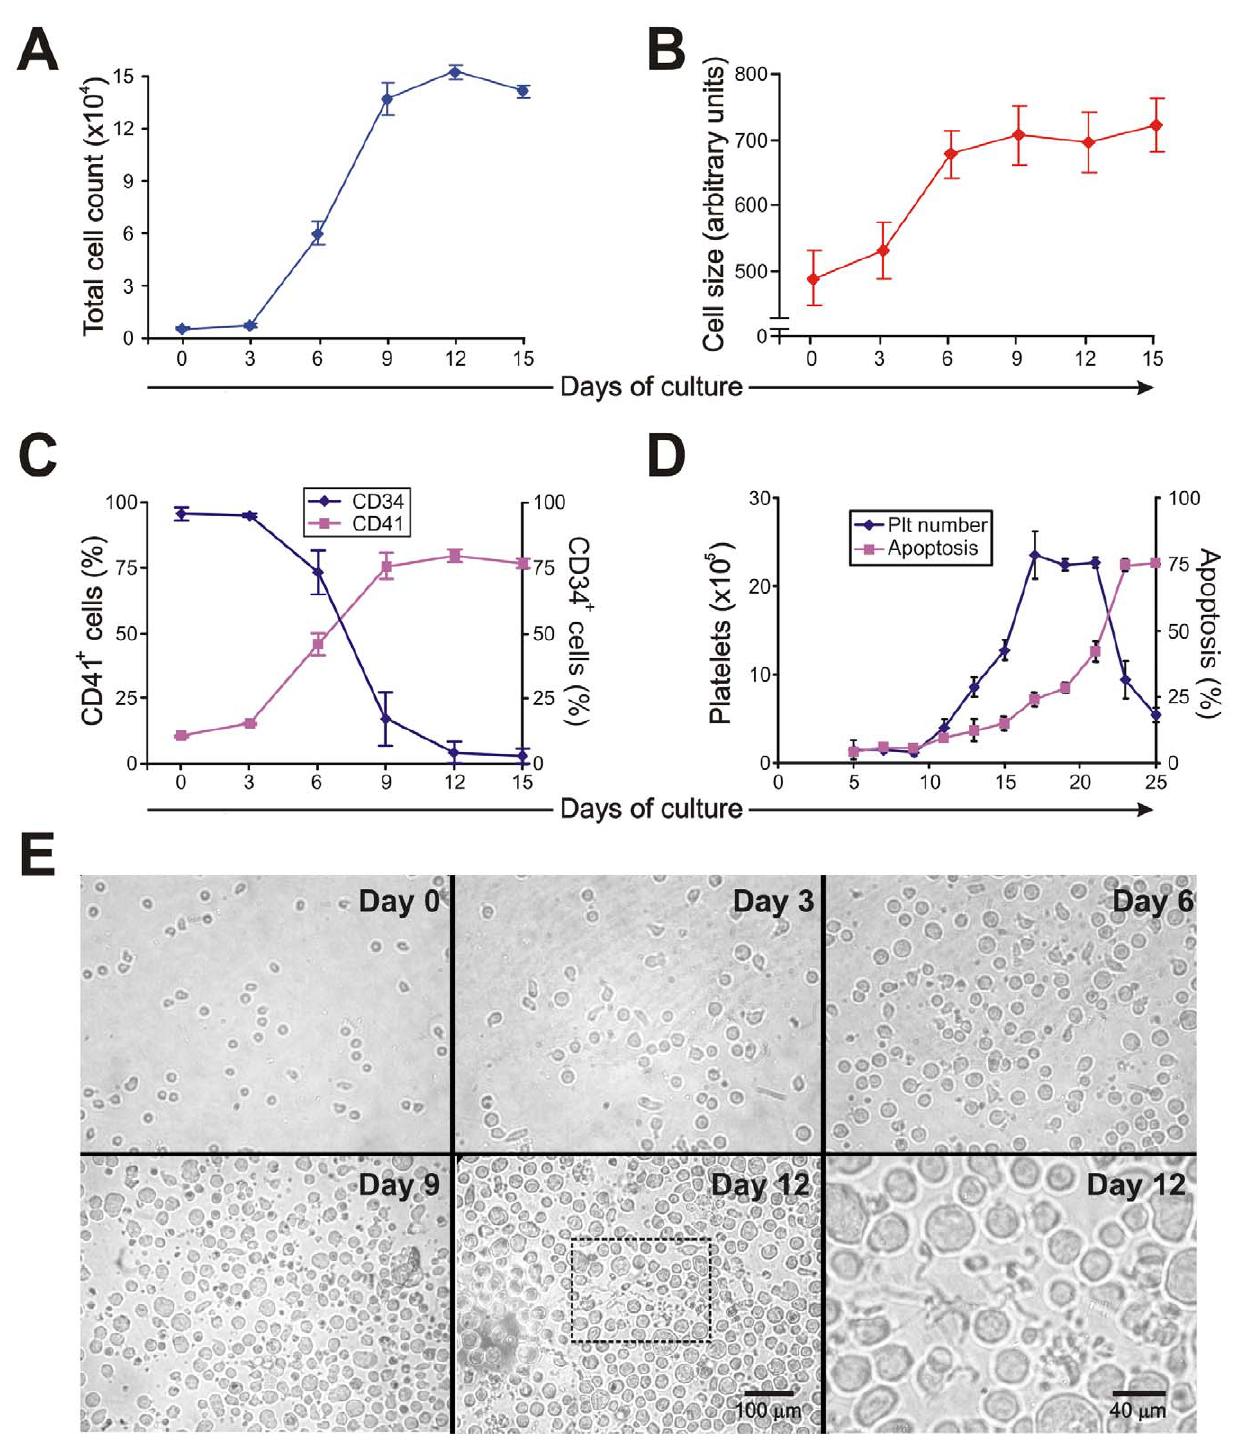
Figure 1. Characterization of liquid cultures of human CD34 + cells stimulated by TPO. CD34 + cells (1 6 10 4 /ml) purified by immunomagnetic positive selection were cultured in IMDM containing 5% human serum and TPO (25 ng/ml added at days one and seven of the cell culture). At the indicated culture times, (A) total cell count was determined with a hemocytometer and (B) cell size was analyzed by flow cytometry. (C) CD41 and CD34 expression were evaluated by labeling cells with specific mAbs or corresponding matched isotypes and establishing the percentage of positive cells by flow cytometry analysis. (D) Platelet (Plt) count was evaluated by flow cytometry and cellular apoptosis was determined by detecting nuclear morphological changes of cells stained with acridine orange and ethidium bromide by fluorescence microscopy. (E) Culture morphology was assessed by phase contrast microscopy [original magnification 450 6 , except day 12 inset (1200 6 )]. The values expressed in panels A–D represent the mean 6 SEM of five independent experiments. Panel E shows a representative experiment of five similar replicates.